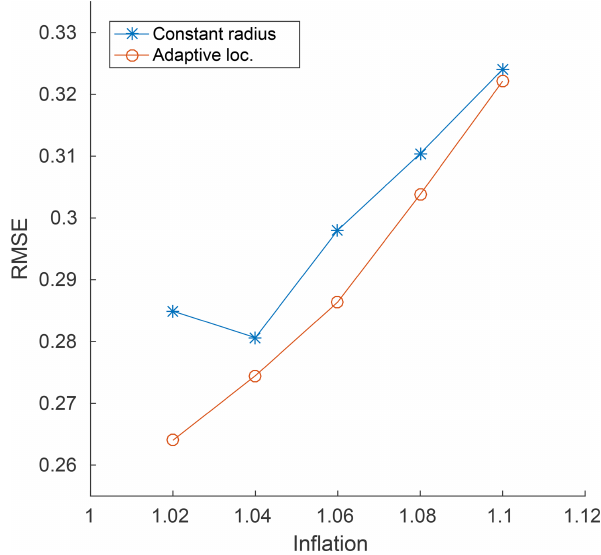
Figure 5. Time-dependent multivariate Lorenz’96 4-D adaptive lo- calization. The constant radius case shows the minimal error when the localization radius is varied between set predefined values. The adaptive localization case has four radii groupings, g = q = 4, with the time-dependence parameter, K = 1. The parameters ¯ υ were var- ied by − 1, + 0, and + 1 from the best constant radius. The parame- ters Var (υ) take one value from { 1 / 4 , 1 , 4 }